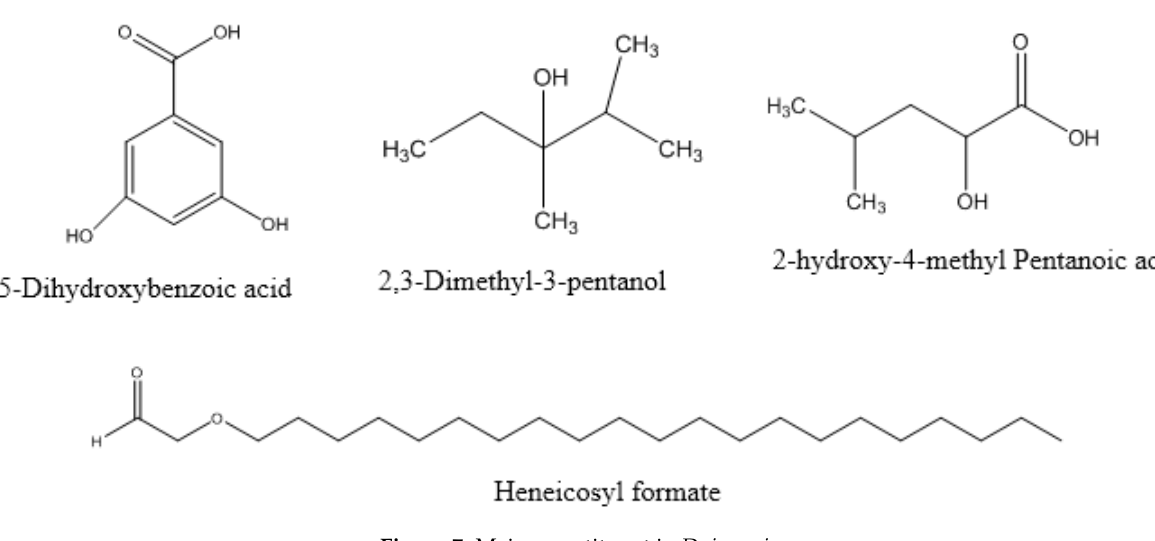
Figure 7. Major constituent in D. innoxia.